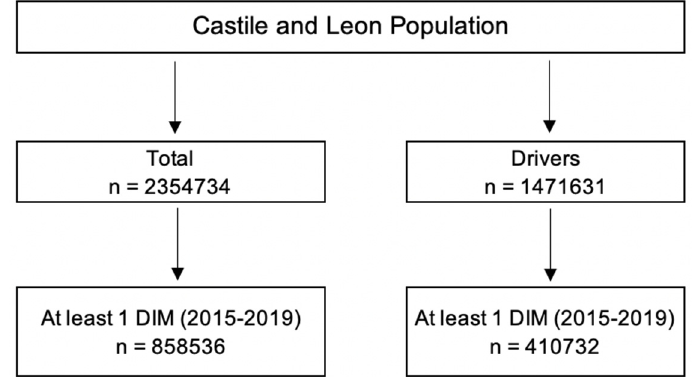
Figure 4. Flowchart of the inclusion of the study population.